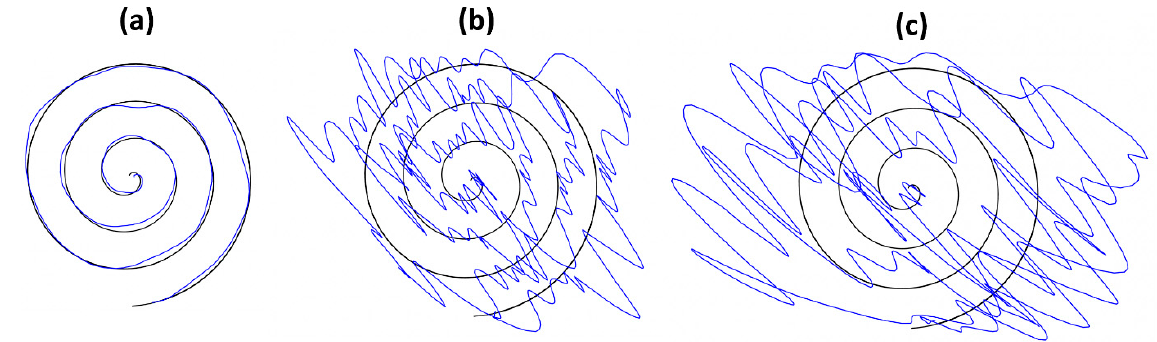
Figure 4. Representative spiral drawings. ( a ) normal condition, ( b ) mild symptoms, and ( c ) severe symptoms.